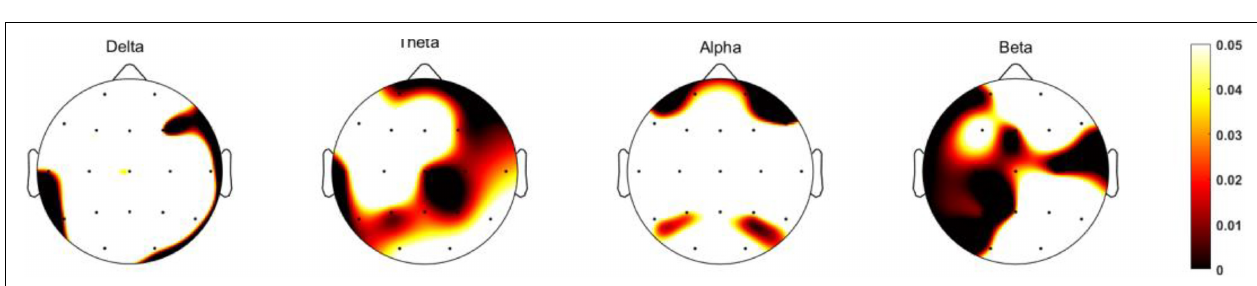
FIGURE 6 | The brain topography of the p -value distribution for EEG power difference between like and dislike decision in different frequency